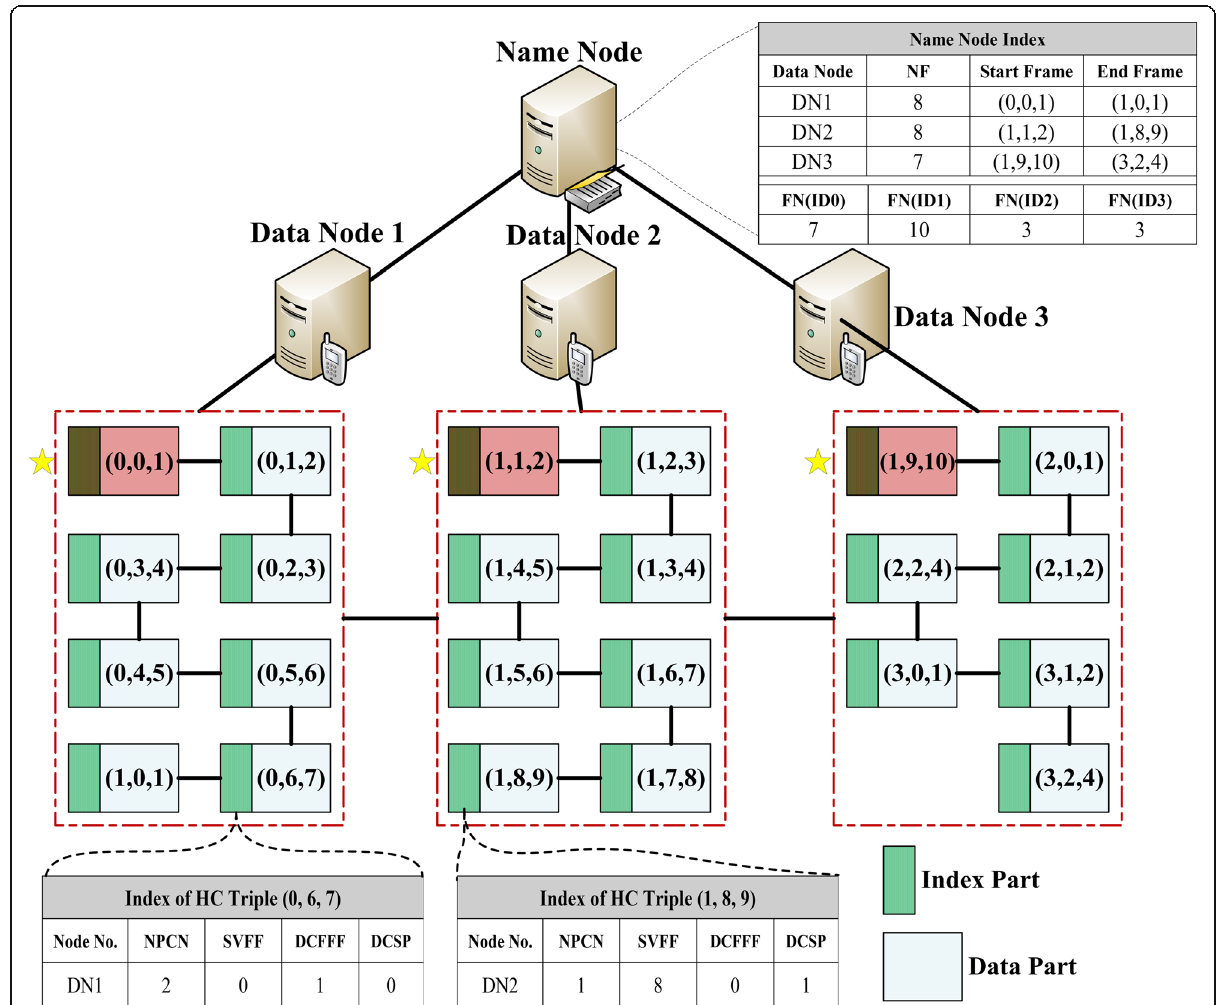
partition ID0), and so